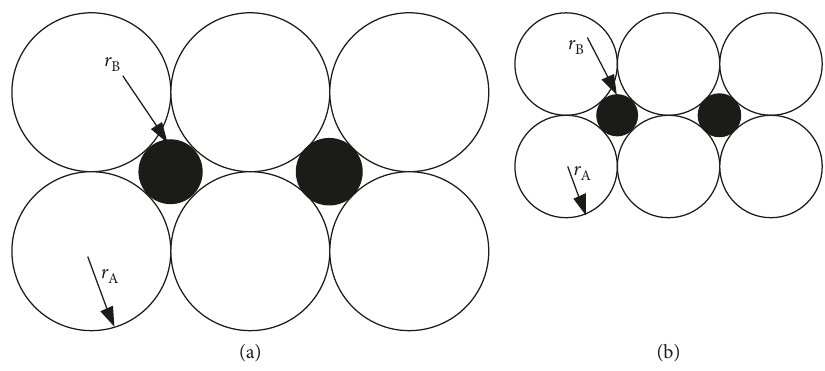
Figure 5: Model of the packed structure of (a) coarse particles and (b) fine particles.